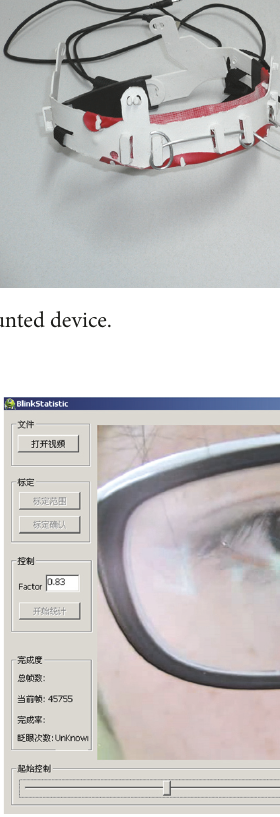
Figure 3: Interface of “blink